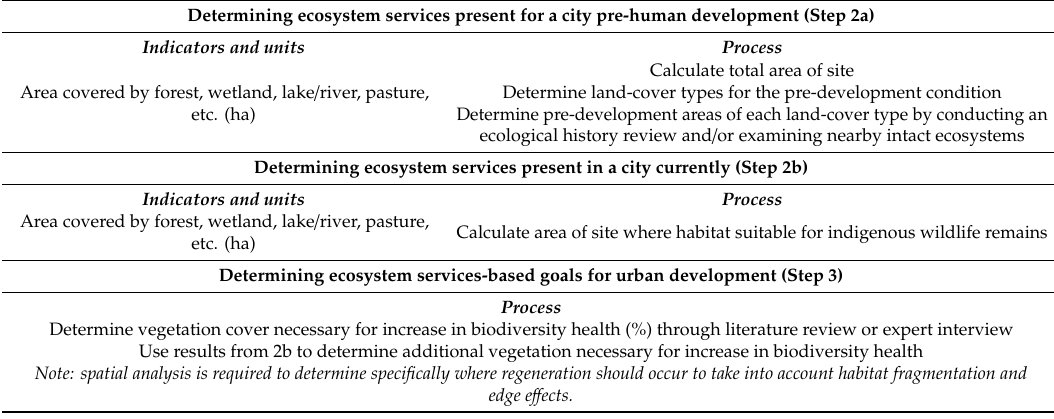
Table 3. Ecosystem services analysis process steps 2a, 2b, and 3 for habitat (adapted from Pedersen Zari